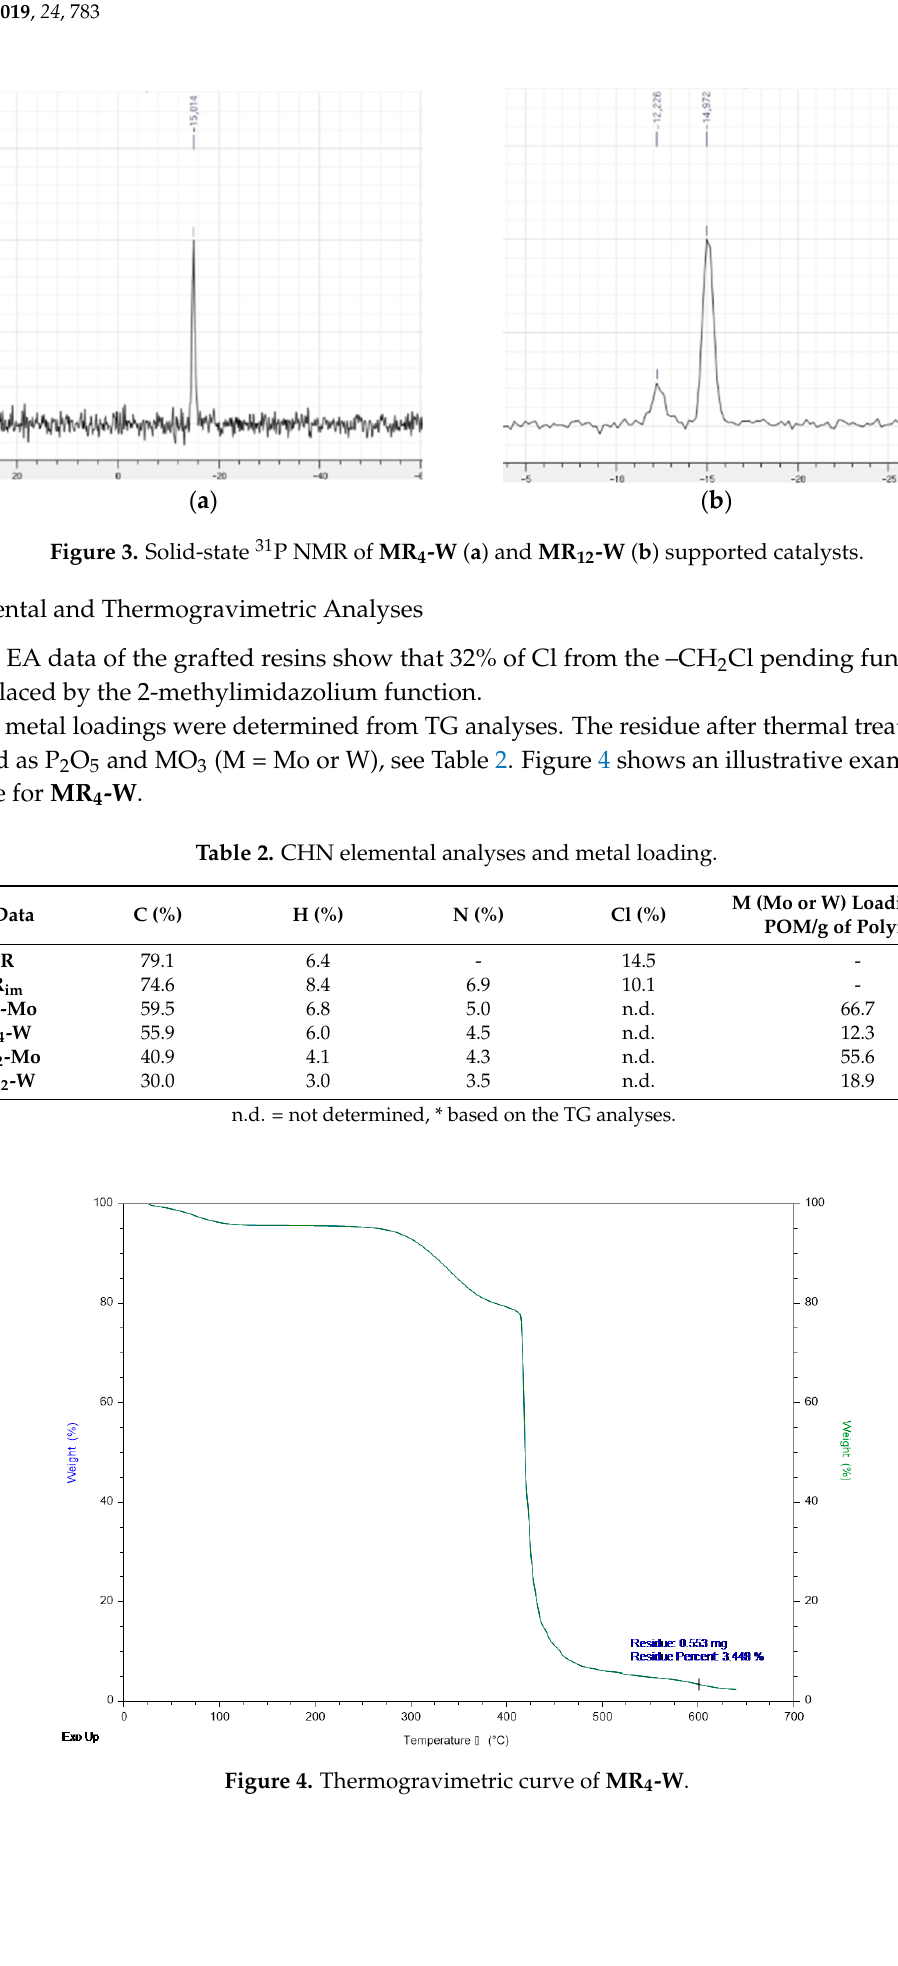
Figure 4. Thermogravimetric curve of MR 4 ‐ W . Table 2. CHN elemental analyses and metal loading.